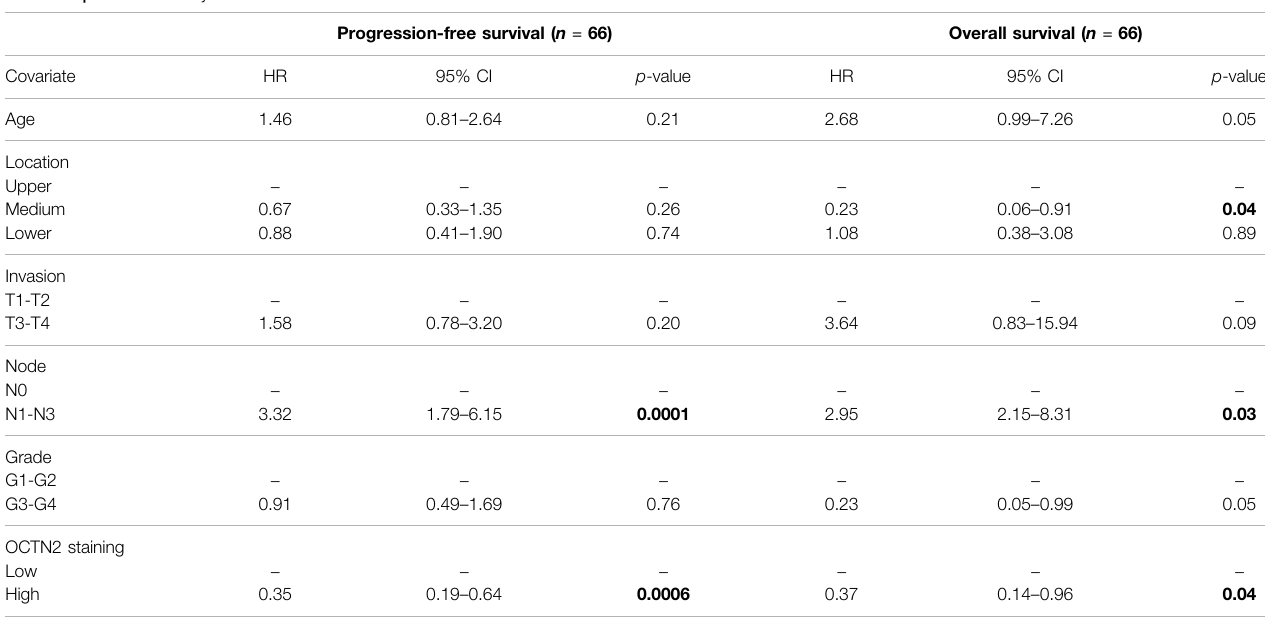
TABLE 2 | Univariate analysis hazard ratios from the Cox PH